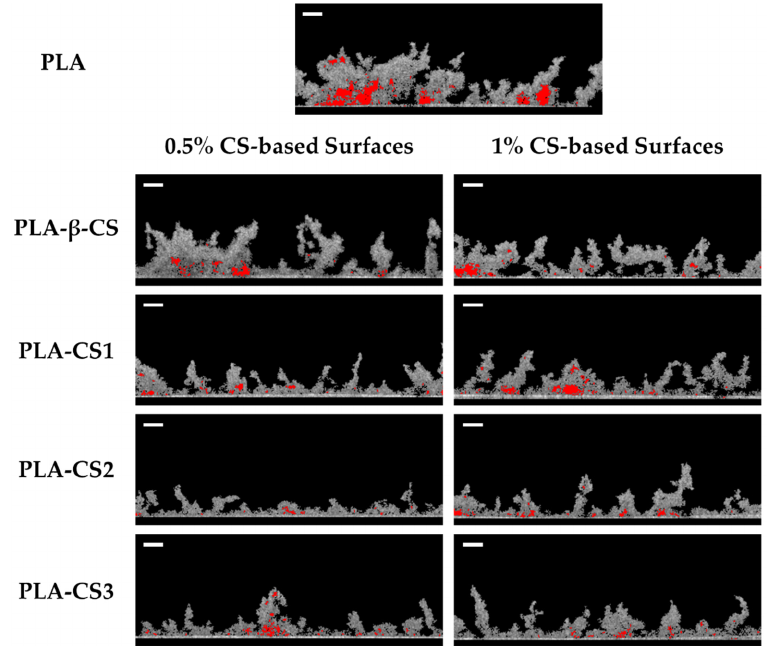
Figure 6. Representative 2D OCT images obtained for C. marina biofilms formed on PLA, and 0.5% and 1% ( w / v ) PLA-CS surfaces (PLA- β -CS, PLA-CS1, PLA-CS2, and PLA-CS3) after 49 days. The empty spaces of biofilms are colored in red. Scale bar = 100 µm.